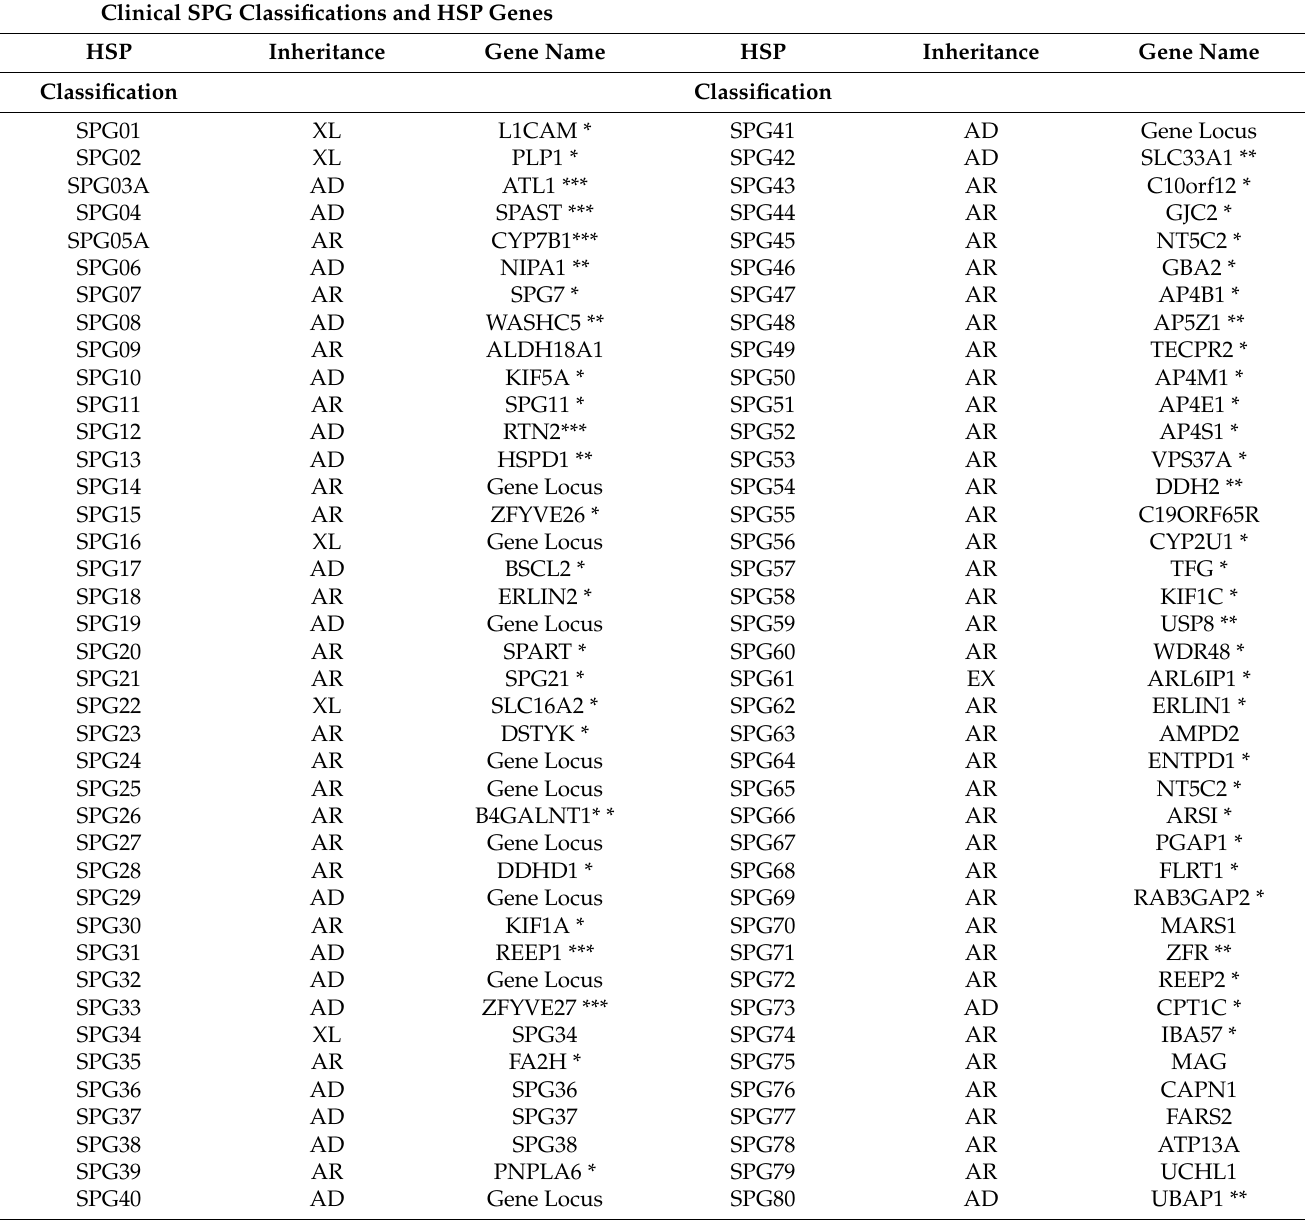
Table 1. Clinical SPG classifications and HSP